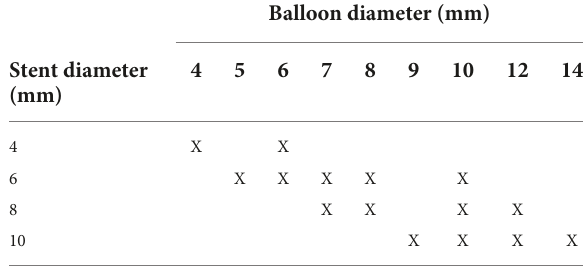
TABLE 2 Balloons used for dilation and overdilating